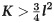
The manufacturer's profit with β in K>34l2.